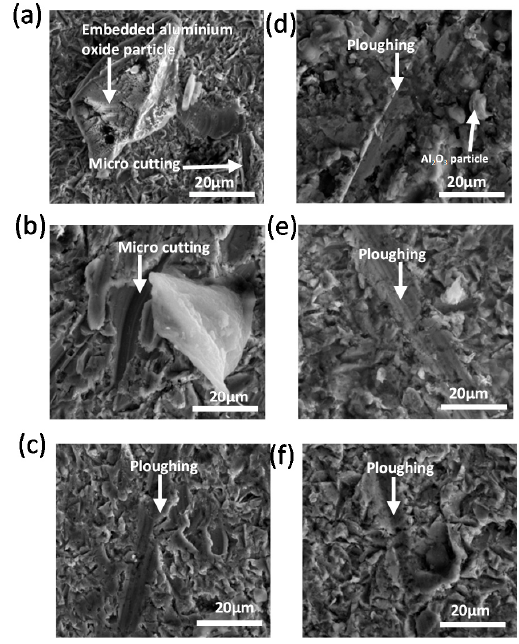
Figure 6. SEM micrographs of 20 m/s at 30° for ( a ) 10 s, ( b ) 300 s, and ( c ) 600 s, and at 90° for ( d ) 10 s, ( e ) 300 s, and ( f ) 600 s.